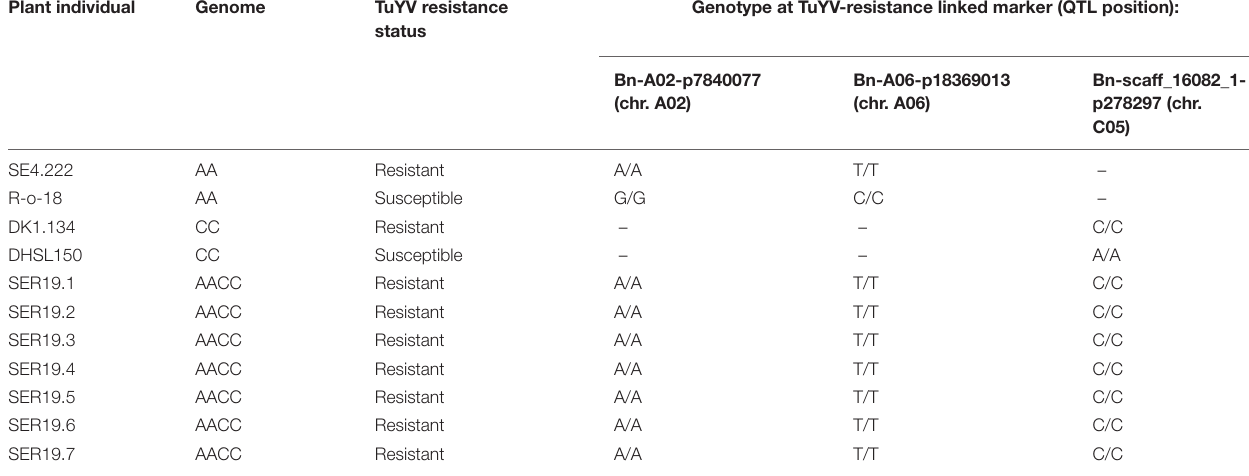
TABLE 4 | Genotype of S 1 individuals SER19.1–7 from population SER19001 derived from the interspecific cross of TuYV-resistant lines ABA15005a ( B. rapa, individual SE4.222) and JWBo12 ( B. oleracea , individual DK1.134) and susceptible diploid B. rapa (R-o-18) and B. oleracea (DHSL150) plants at TuYV resistance-linked markers identified from QTL